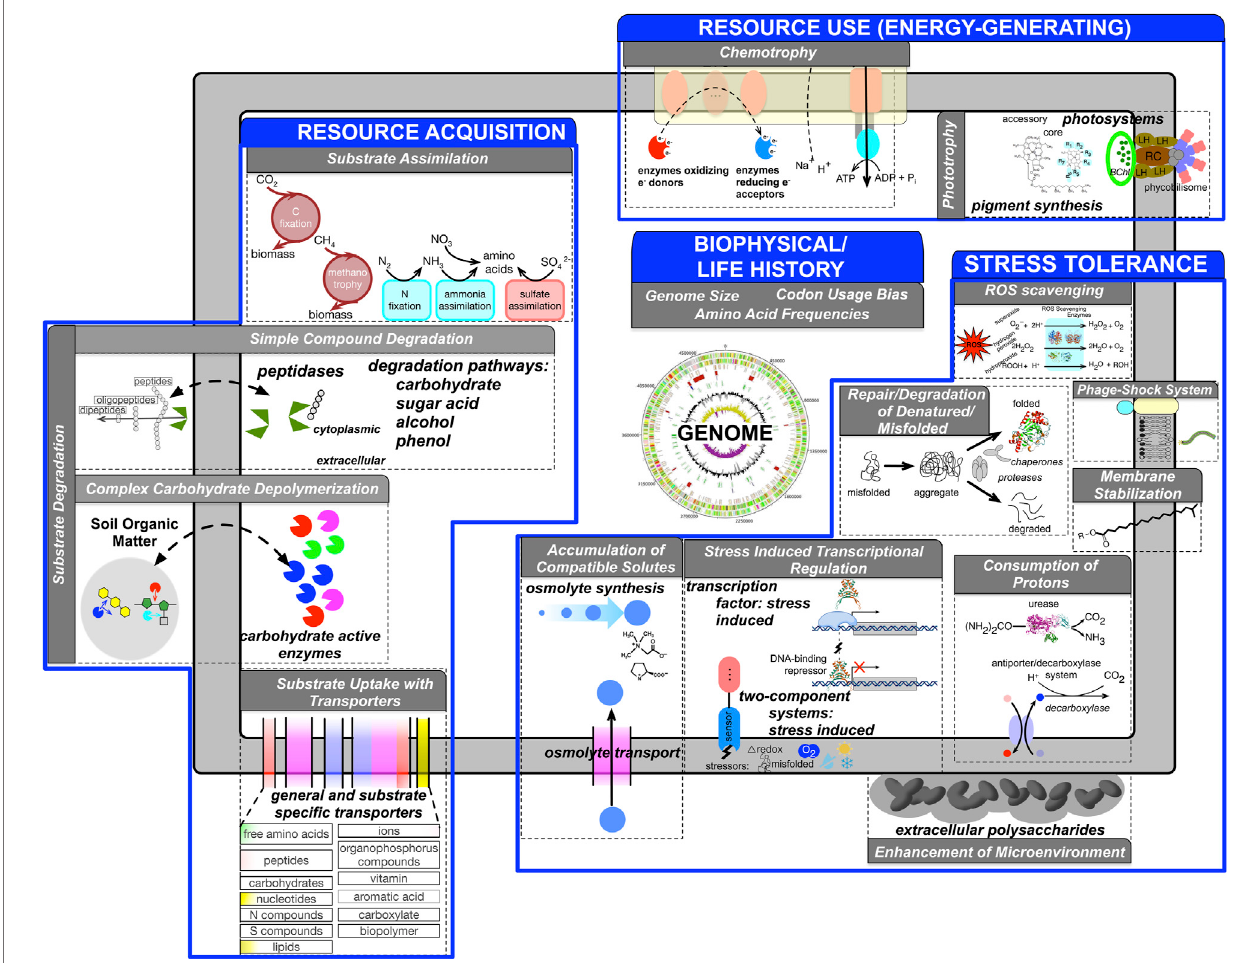
FIGURE1| Conceptualoverviewofgenome-derivabletraits(grayboxes)underlyingecologicalstrategies(blueboxes)representedin microTrait basedonliterature surveys. For each trait, genomic features are indicated. Supplementary Table S1 provides full details for the microTrait hierarchy. Supplementary Table S8 lists references for genomic features underlying ecological